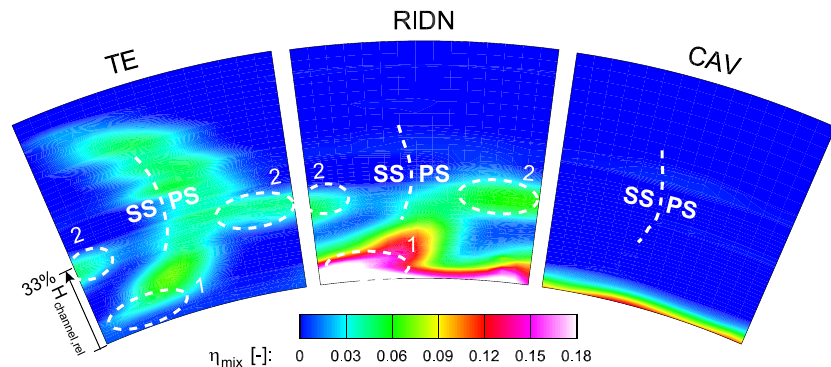
Figure 4. Flow tracing MFR 3, propagation of the coolant